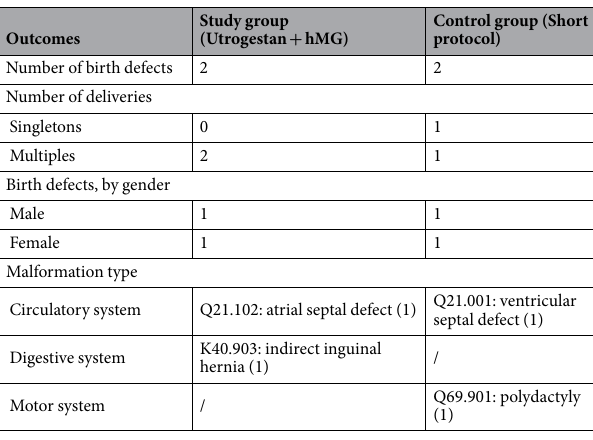
Table 3. Types of congenital malformations among 546 live-born